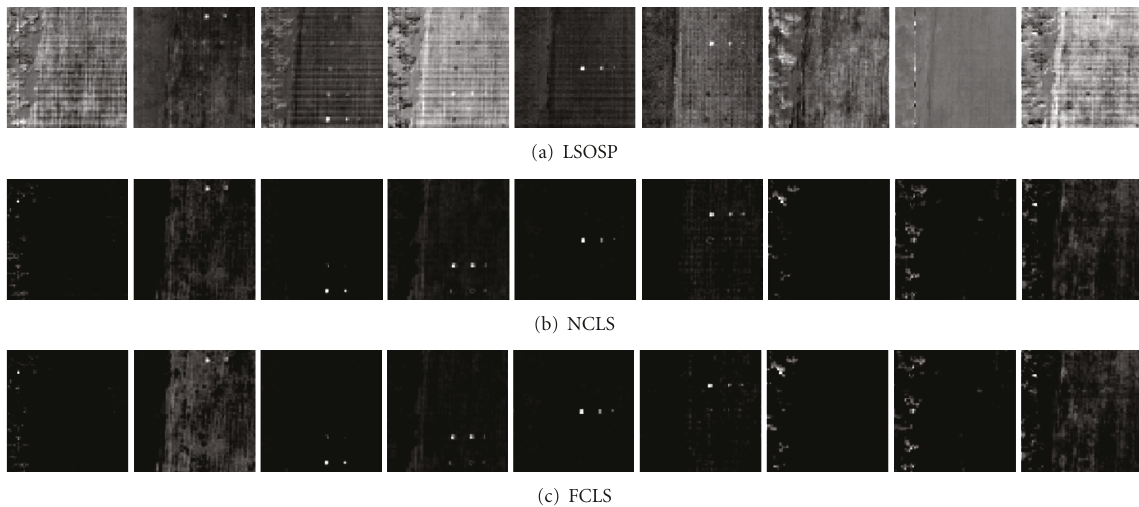
Figure 24: 9 target classes obtained by LSOSP, NCLS, and FCLS using the target pixels generated by UNCLS-USTFA.